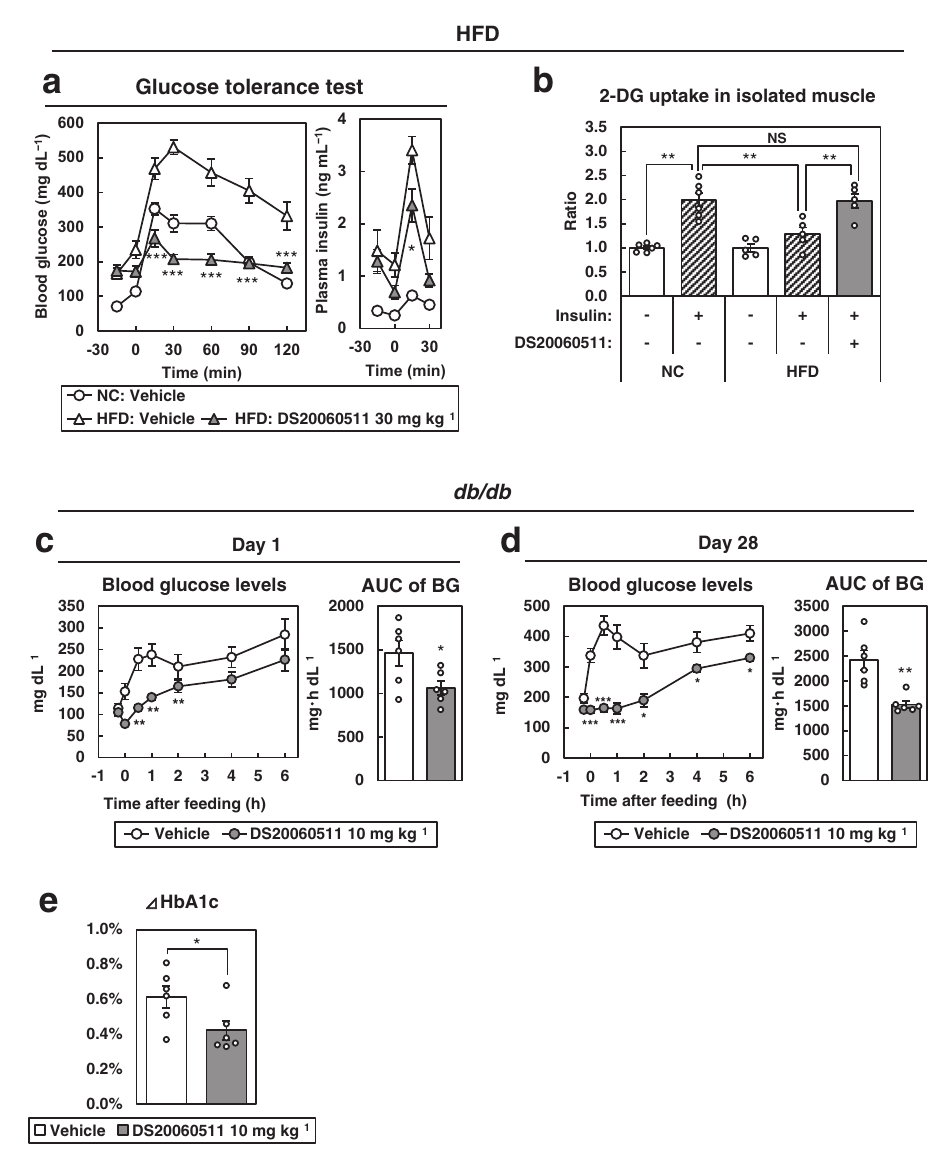
Fig. 8 Acute and chronic DS20060511 treatment improves glucose intolerance in HFD-fed and db/db mice. a Blood glucose and plasma insulin levels during an oral GTT in normal-chow (NC)- and high-fat diet (HFD)-fed mice ( n = 5). Vehicle or DS20060511 (30 mg kg − 1 ) was given orally 15 min before the oral glucose administration (1.5 g kg − 1 ). Values shown are means± SEM. * P < 0.05, ** P < 0.01, *** P < 0.001 vs. the HFD vehicle by the t -test. b Effects of 10 μ M DS20060511 and 100 nM insulin on 2-DG uptake in muscles isolated from NC-fed ( n = 6) and HFD-fed ( n = 5) mice. Values shown are means ± SEM. ** P < 0.01 by one-way ANOVA followed by Tukey ’ s test. c , d Changes in the blood glucose levels and AUC on day 1 and day 28 during refeeding ( n = 6) in db/db mice treated chronically with DS20060511 (10 mg kg − 1 day − 1 ). Values shown are means± SEM. * P < 0.05, ** P < 0.01, *** P < 0.001 vs.